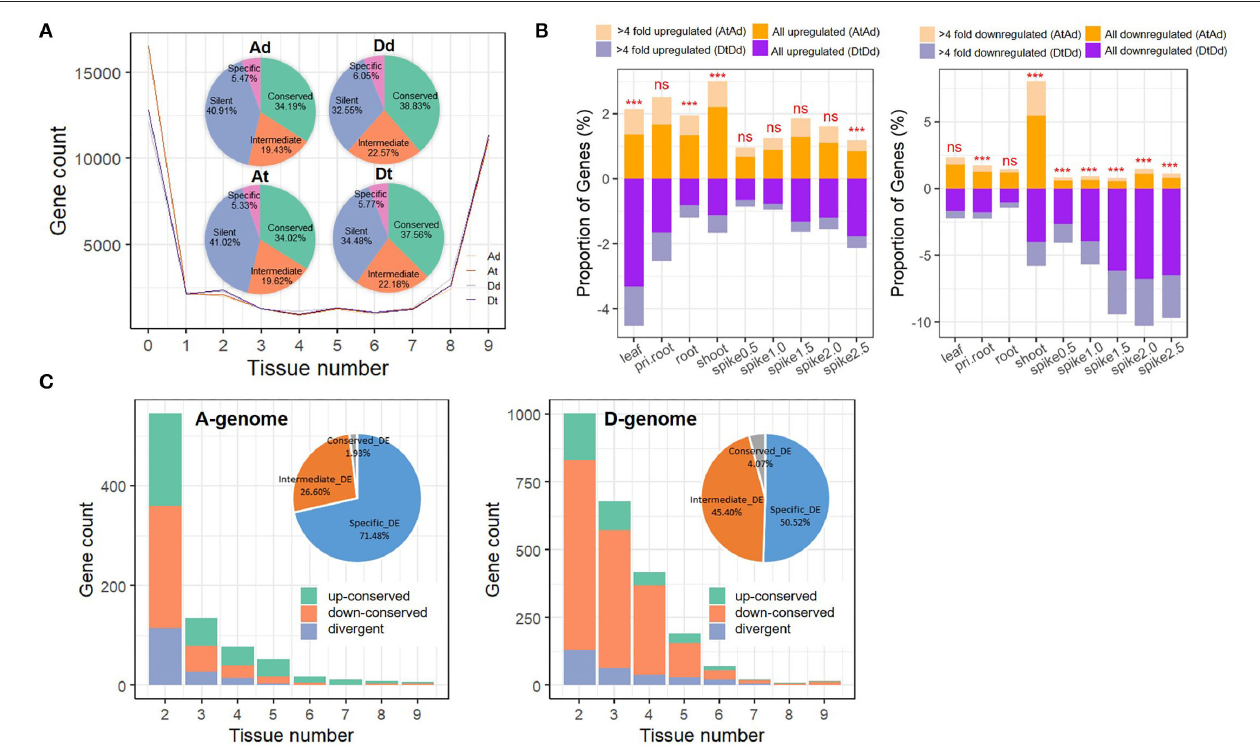
FIGURE 2 | Asymmetric expression response of subgenomes to allopolyploidy in AT2. (A) Gene expression patterns among nine tissues/stages in AT2 and parents. Gene expression distributions of different tissues/stages among genomes/subgenomes are shown in the line chart. The numbers of genes that marked as “silent” (without expression in any tissue; 0 tissue), “specific” (TPM > 1 in one tissue), “intermediate” (TPM > 1 in 2–7 tissues) and “conserved” (TPM > 1 in 8–9 tissues) among genomes/subgenomes are specified in the pie chart; (B) The proportion of up/downregulated genes (At vs. Ad and Dt vs. Dd) in different tissues/stages. Respective statistical significance of difference in the number of DEGs between A and D subgenomes is specified above each column (***denotes significance at p -value < 0.001; ns denotes “no significance”); (C) Conservation of DEGs among tissues/stages in A (the left panel) and D (the right panel) subgenomes. The number of three gene groups genes, including “up-conserved” (genes in all given tissue numbers are upregulated, green color) and “down-conserved” (genes in all given tissue numbers are downregulated, orange color) and “divergent” (genes in some tissues are downregulated but upregulated in other tissues, blue color) groups, are shown in barplot. DEGs occurred in only one tissue (specific_DE, blue color), 2–7 tissues (intermediate_DE, orange color) and 8–9 tissues (conserved_DE, gray color) are presented in the pie